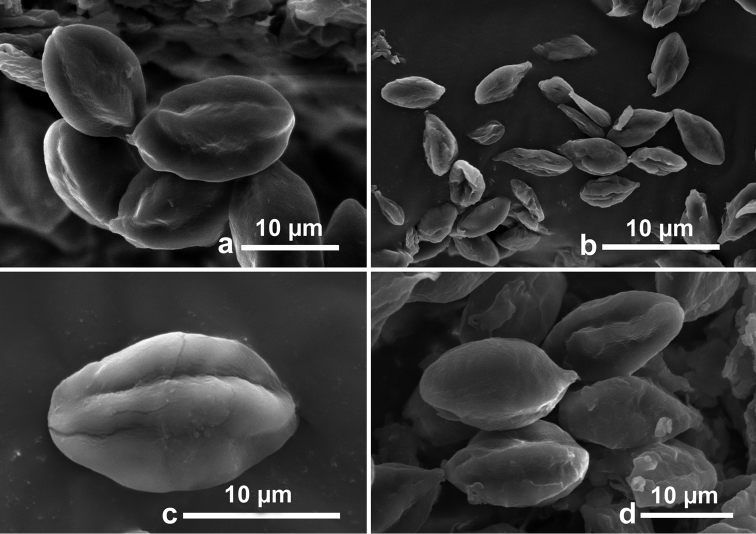
SEM of basidiospores of Rossbeevera species. a, bRossbeeverabispora (aGDGM 45612 bGDGM 45639) c, dRossbeeveragriseobrunnea (cGDGM 45266 dGDGM 45913, holotype).